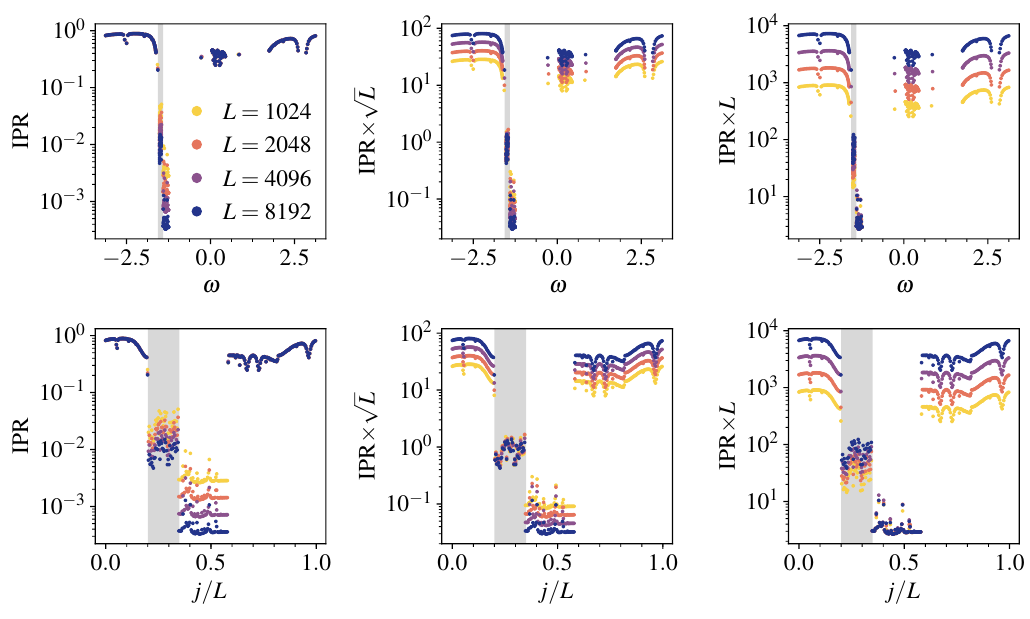
Figure 12: IPRs as a function of quasienergies. The top row panels show the IPRs unscaled, (cid:112) L and L , respectively as a function of quasienergy ω . The gray shaded win- scaled with dows denotes the multifractal states, IPRs of which show reasonable collapse for various L (cid:112) L . To clarify that there are a macroscopic number of multifractal states in when scaled with the narrow quasienergy band, in the bottom panel we plot the same data but as function of quasienergy